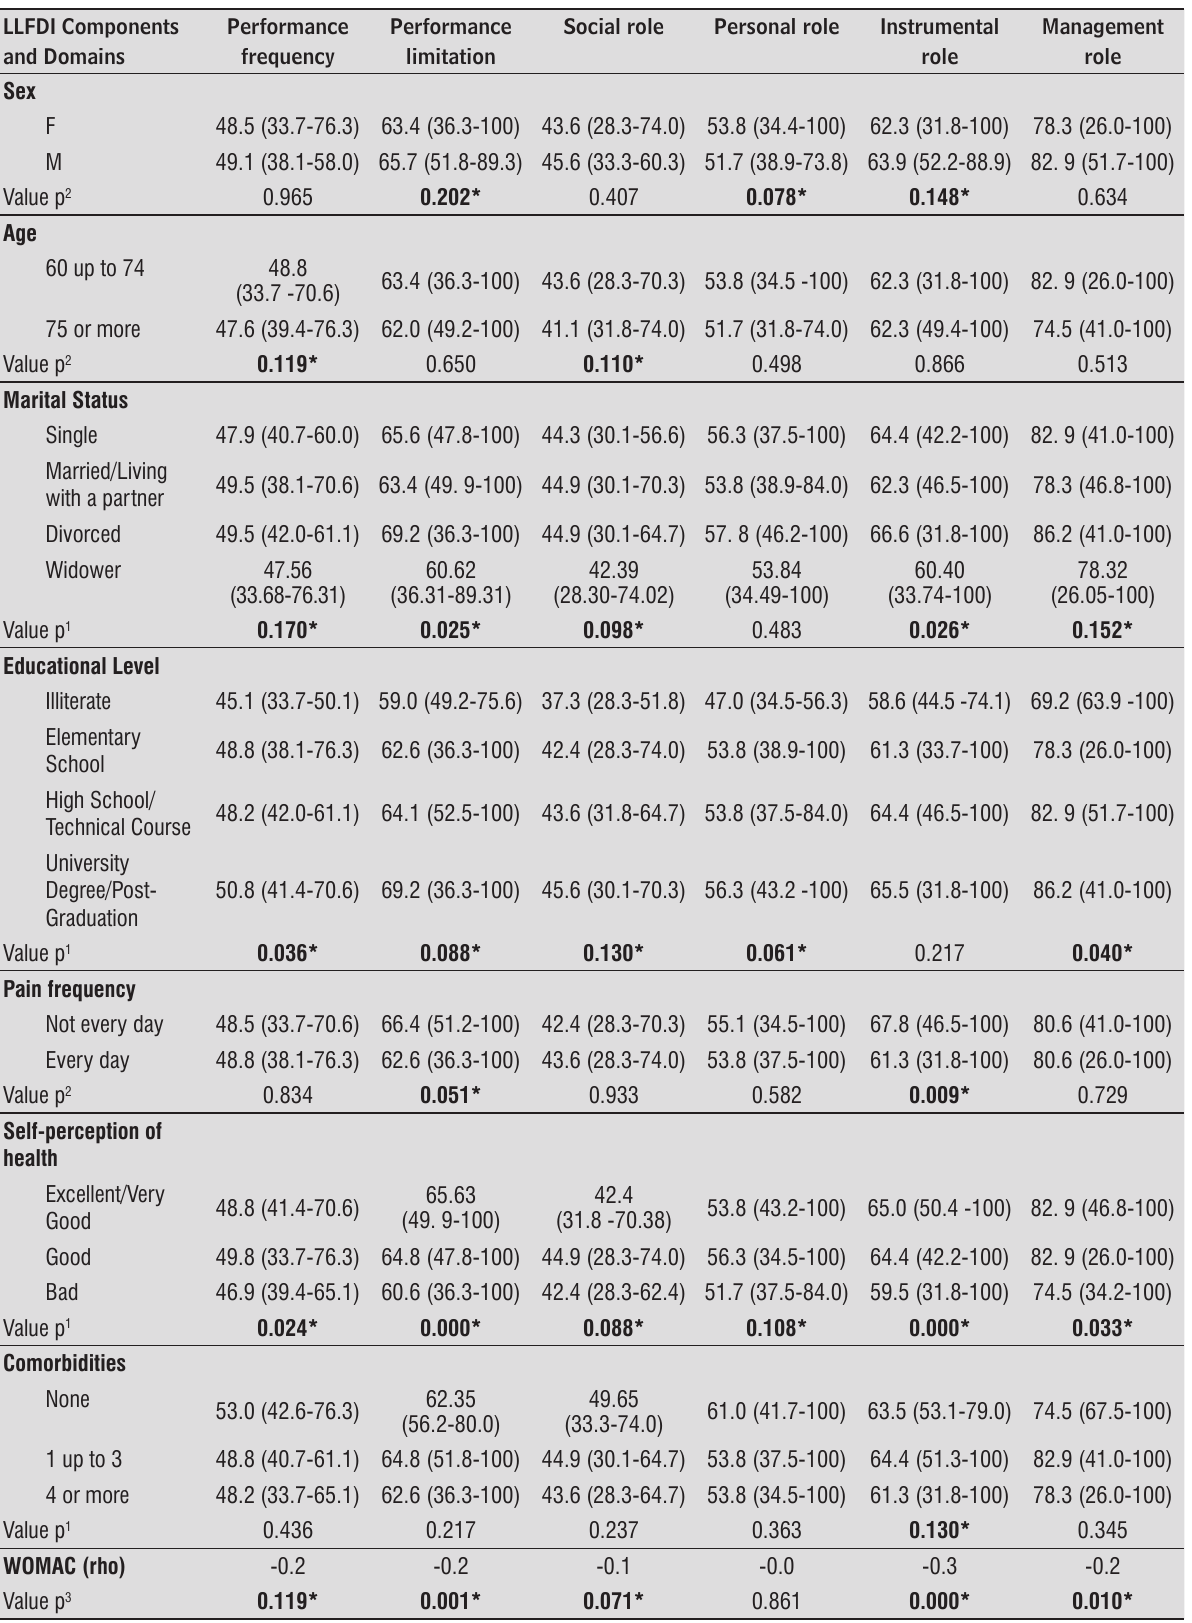
Table 3 - Bivariate analysis of factors associated with LLFDI dimensions and areas LLFDI